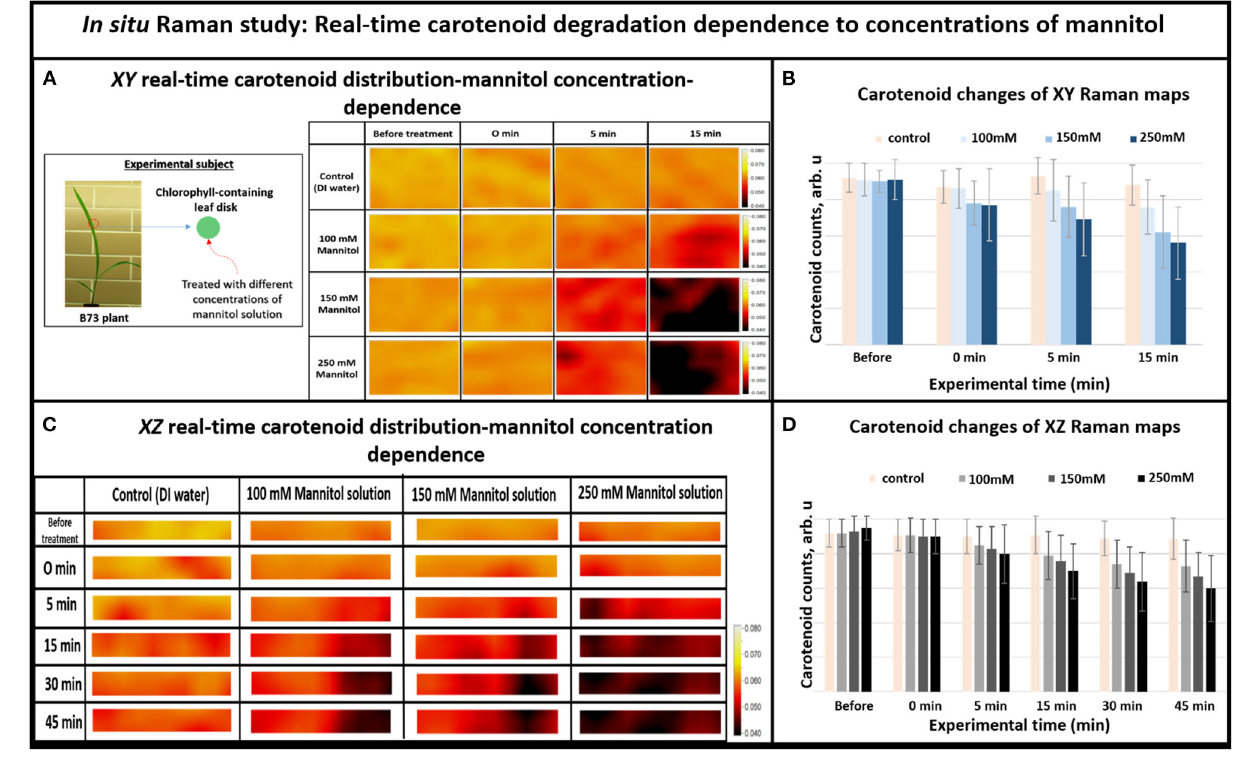
FIGURE 3 | (A) XY Real-time carotenoid distribution changes depend on the mannitol concentrations of 0, 100, 150, and 250mM, before the treatments and 0, 5, and 15min after the treatments (the green leaf disks-areas of 170 × 140 µ m), (B) Histogram of carotenoid changes of XY Raman maps. Each bar represents mean + SD ( n = 80 × 3 × 2), (C) XZ Real-time carotenoid distribution changes depend on the mannitol concentrations of 0, 100, 150, and 250mM, before treatments and 0, 5, 15, 30, and 45min after the treatments (the green leaf disks where z is depth inside the tissue-areas 170 × 2 µ m), (D) Histogram of carotenoid changes of XZ Raman maps. Each bar represents mean + SD ( n = 30 × 3 ×